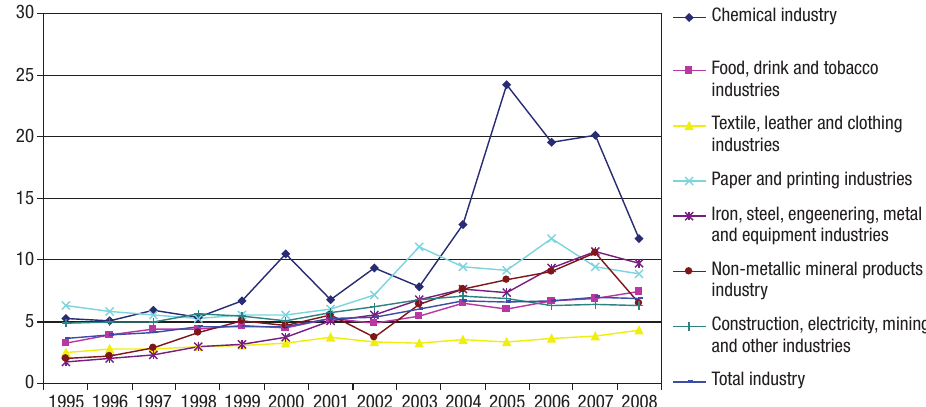
Fig. 5. Labour productivity of Lithuania‘s industrial sectors during 1995–2008 Source : Data from EUROSTAT, index calculated by authors (Labour productivity is as a ratio of output per labour-hour to an input; where labour productivity = Gross Value Added, EUR / Worked hours,